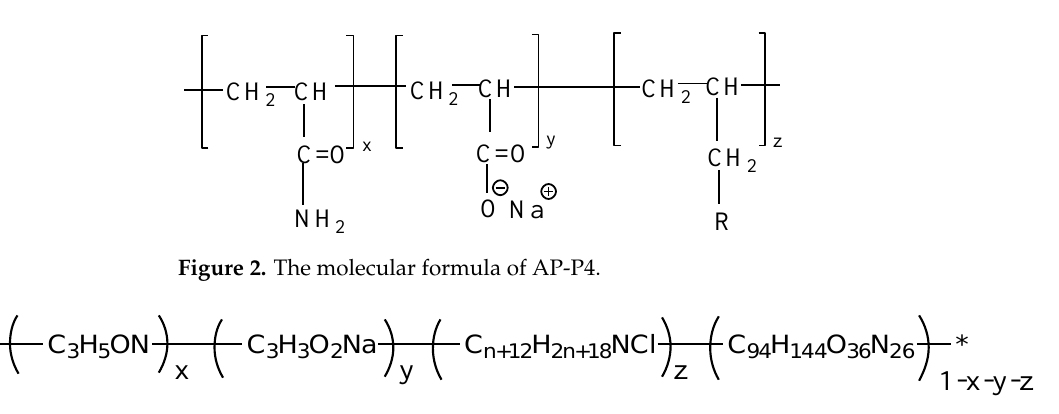
Figure 3. The molecular formula of DHAP.